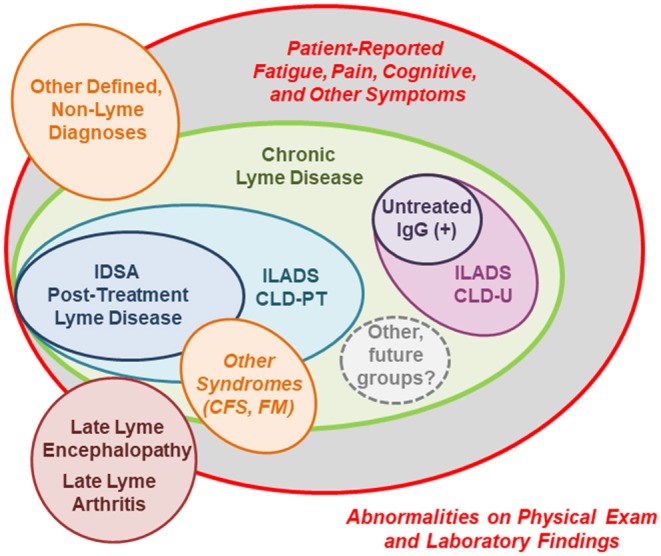
A schematic of clinical- and research-defined patient subgroups among those with persistent symptoms associated with Lyme disease (14, 163, 174). The size of each patient subgroup is not meant to represent actual population frequency, as prevalence data is extremely limited. IDSA, Infectious Diseases Society of America; ILADS, International Lyme and Associated Diseases Society; CLD-PT, Chronic Lyme Disease-Previously Treated; CLD-U, Chronic Lyme Disease-Untreated; IgG, Immunoglobulin G; CFS, Chronic Fatigue Syndrome; FM, Fibromyalgia.